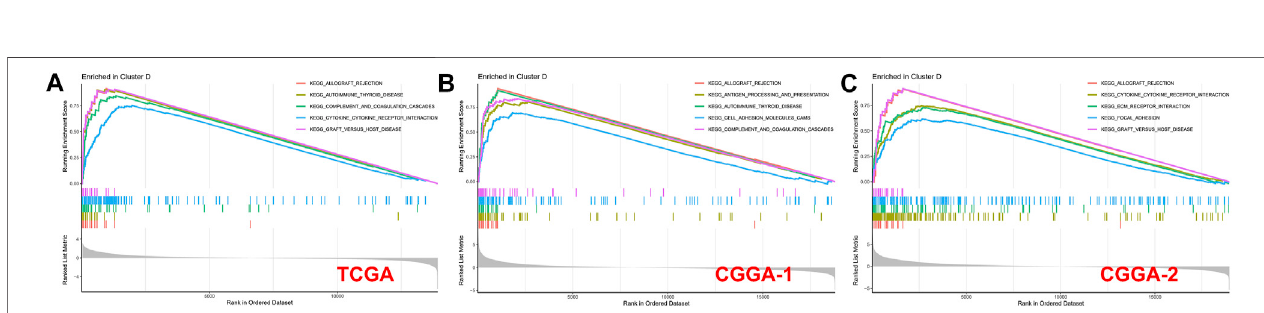
FIGURE9| GSEA enrichmentanalysisfor clusters Aand D in (A) TCGA, (B) CGGA-1, and (C) CGGA-2 datasets.Nosigni fi cantenrichmentwasfound incluster A with a threshold of FDR < 0.05.